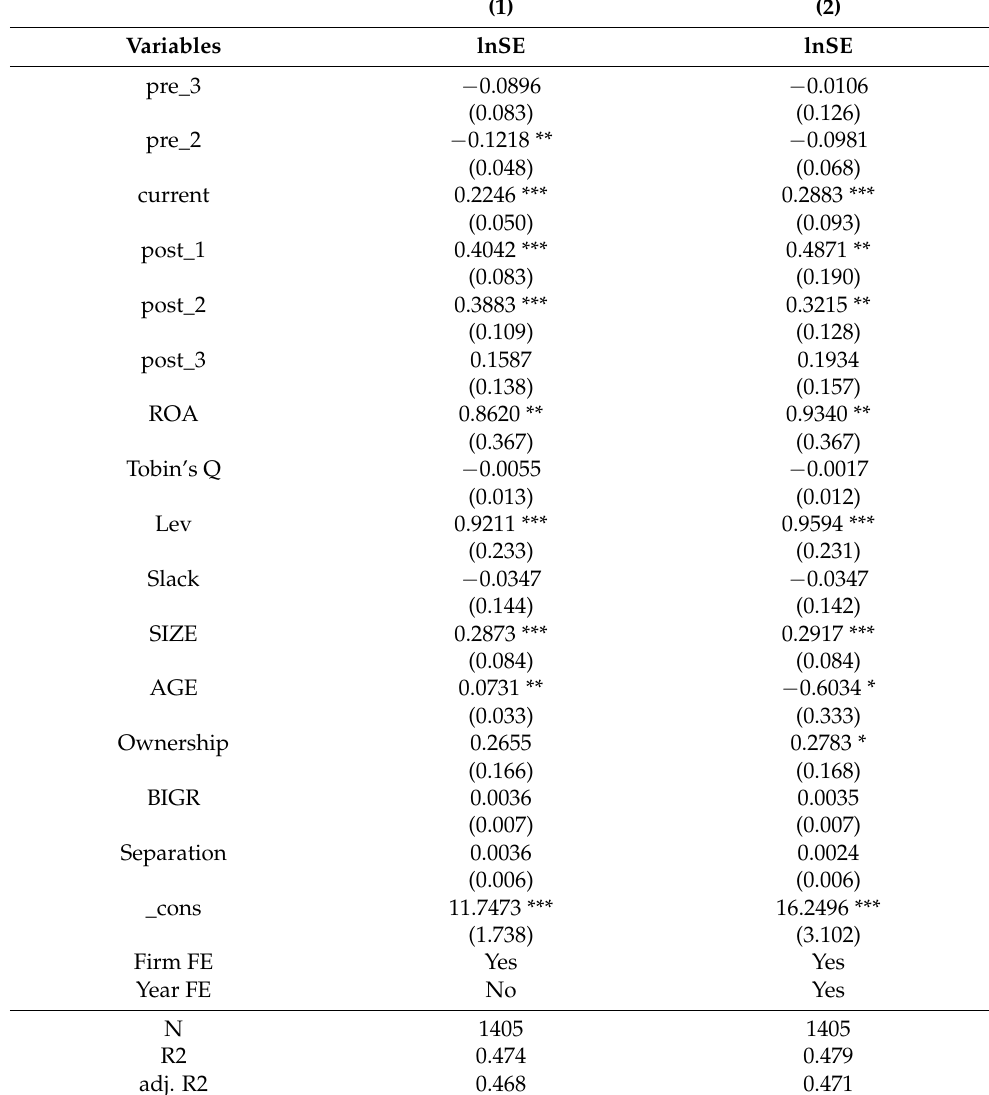
Table 4. The Dynamic Impact of Two-Invoice System on Selling